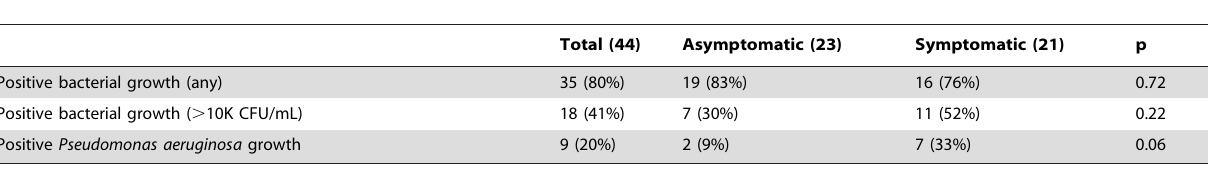
Table 3. Culture Results of Lung Transplant BAL Specimens.